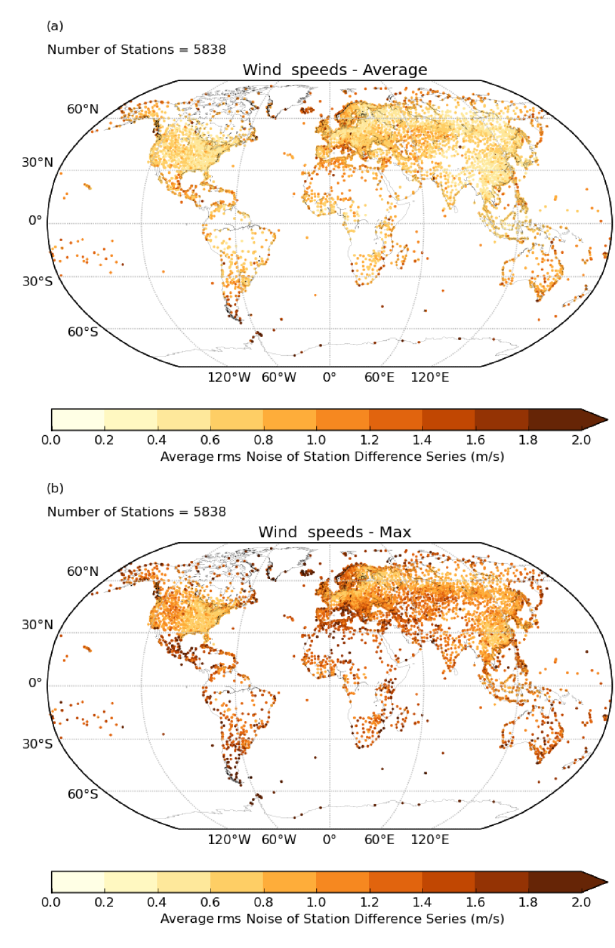
Figure A5. The average rms difference for the neighbours from each station for (a) the monthly-average wind speed and (b) the monthly-average maximum wind